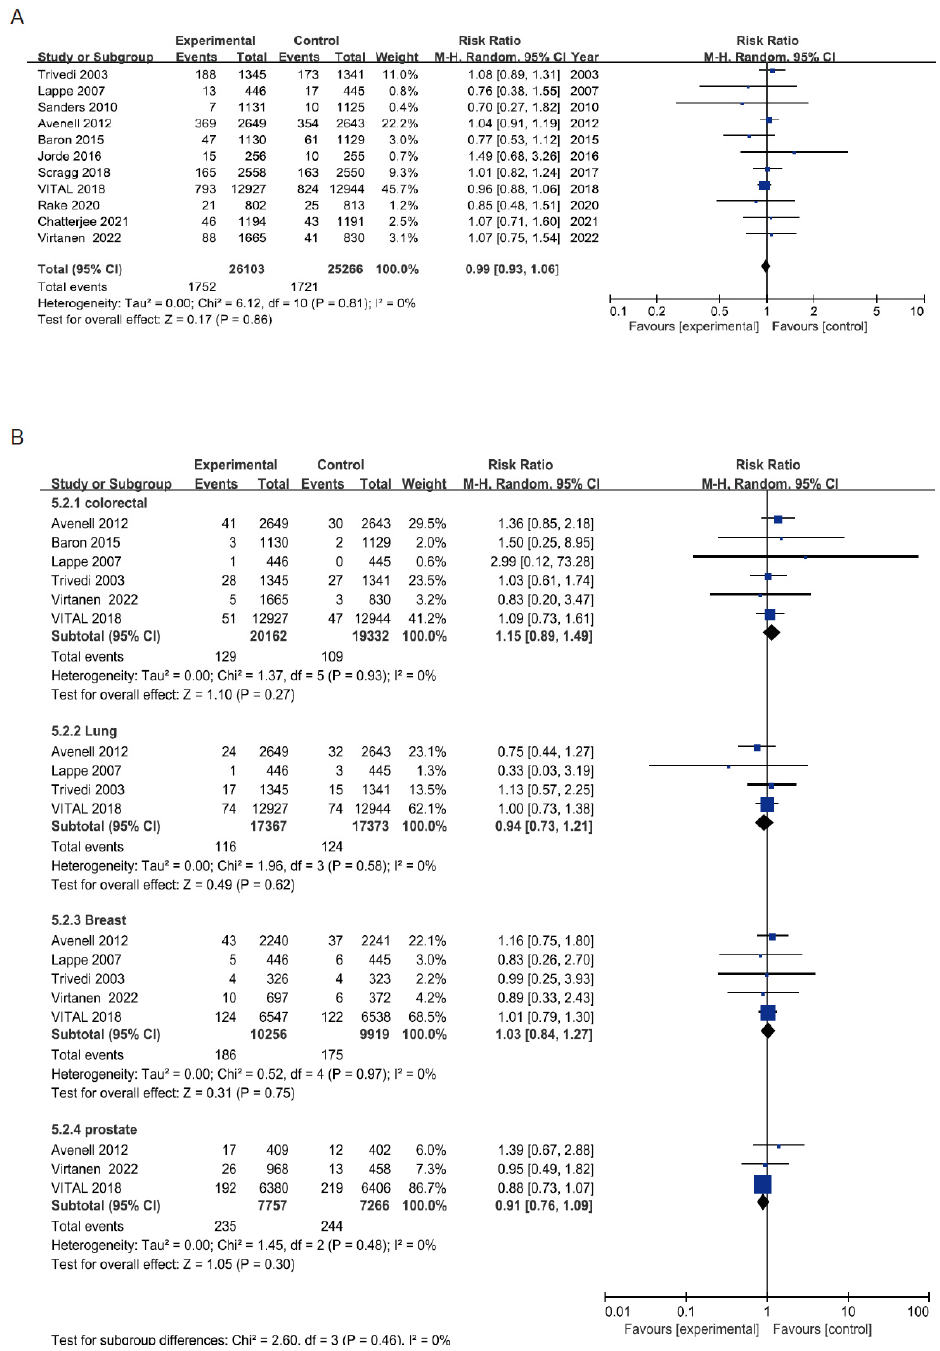
Figure 4. The forest plot of vitamin D supplementation and cancer incidence. ( A ) overall cancer incidence, ( B ) site-specific cancer incidence.